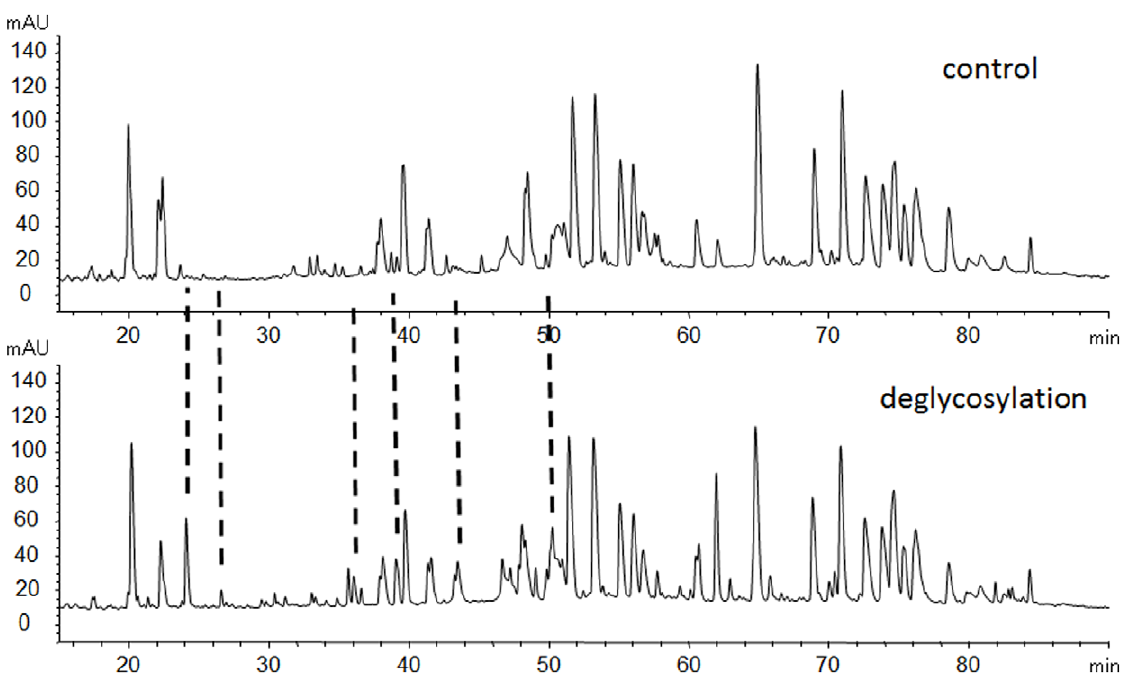
Figure 3. Peptide mapping of conbercept without (up) and with PNGase F treatments (bottom).